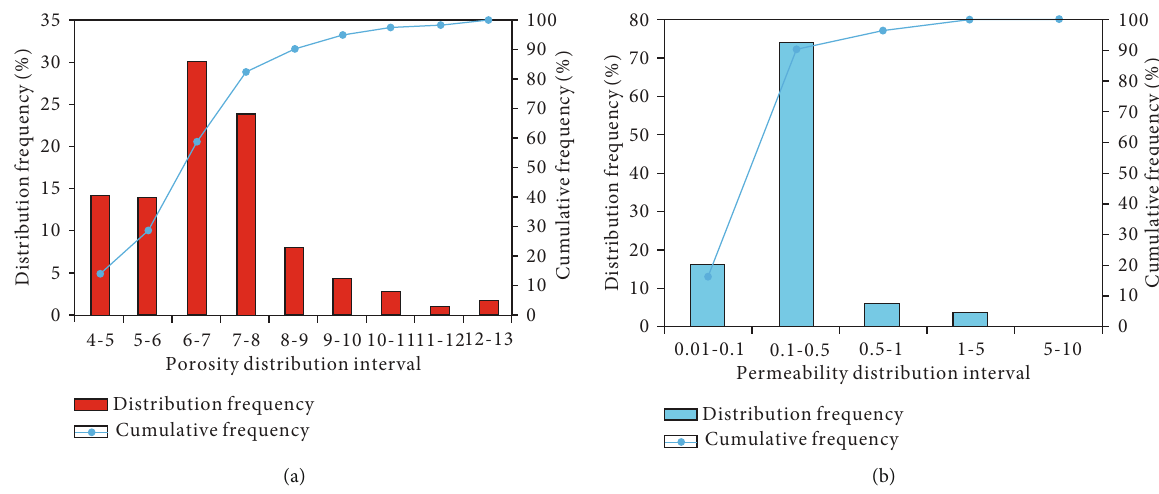
Figure 15: Porosity and permeability distribution frequency and cumulative frequency in the study area: (a) histogram of porosity distribution frequency; (b) histogram of permeability distribution frequency.